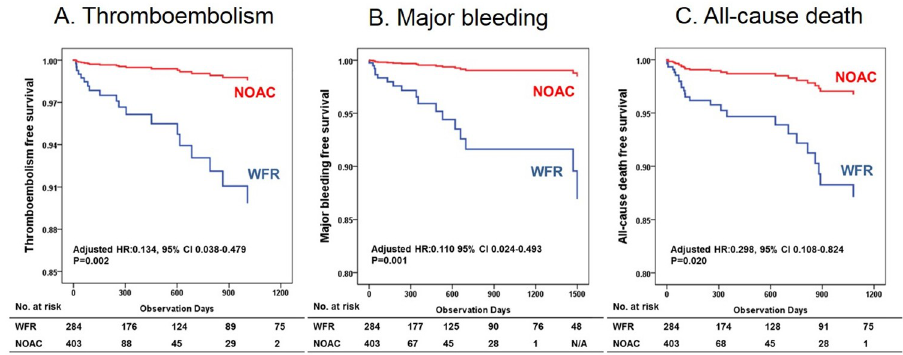
Fig 2. Risk-adjusted event-free survival according to the treatment. Event-free survival curves are demonstrated according to the treatment, adjusted for age, sex, previous history of hypertension, diabetes mellitus, congestive heart failure, vascular disease and stroke history. A) Event-free survival curve for thromboembolism, B) Event-free survival curve for major bleeding, C) Event-free survival curve for all-cause death. NOAC, non-vitamin K antagonist oral anticoagulants; WFR,